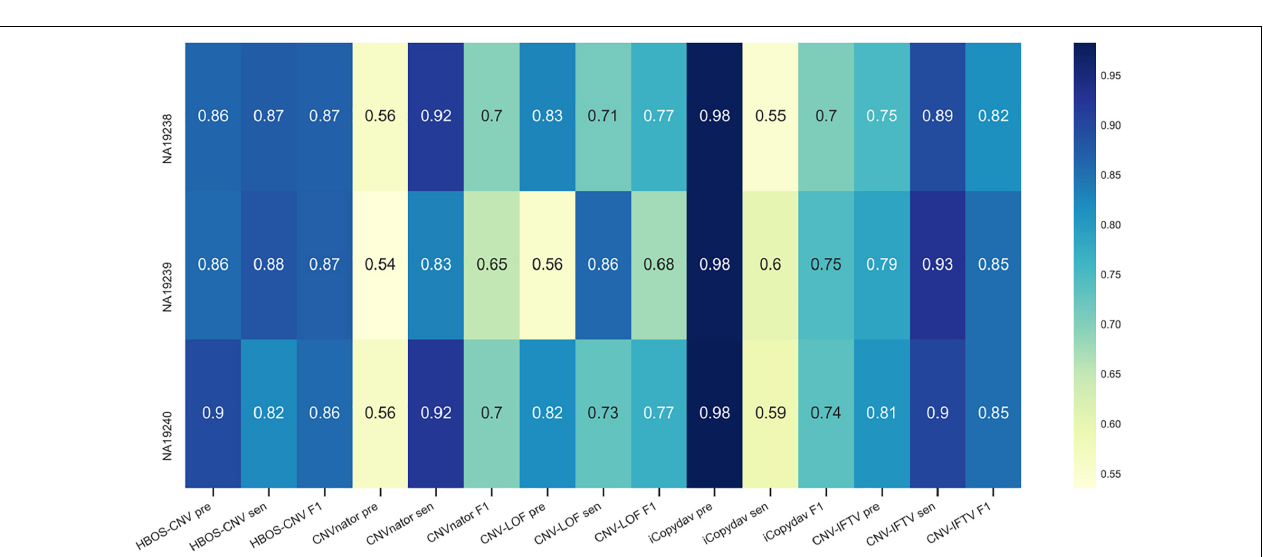
FIGURE 6 | The x -axis represents the precision, sensitivity, and F1-score of the five methods, and the y -axis represents the three samples (NA19238, NA19239, NA19240). The precision, sensitivity, and F1-score of each method are marked in the figure.